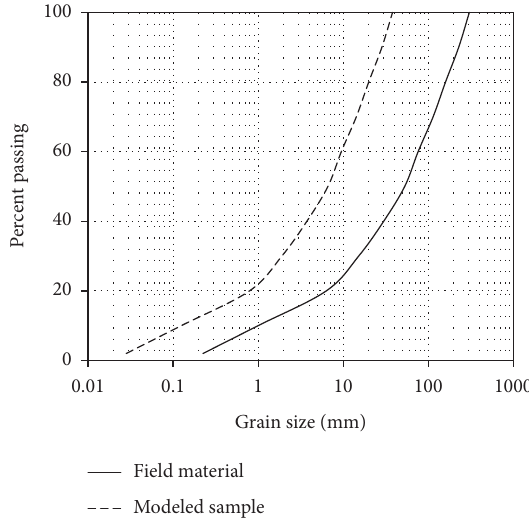
Figure 4: Grain size distribution curves of the field material and parallel sample (data taken from